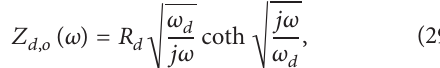
Figure 5: Complex plane plots for the impedances that show inductive effects at (a) the high frequency and (b) the low frequency regions. Inset shows the corresponding equivalent circuits with 𝑅 𝑠 = 10 Ω , 𝑅 for